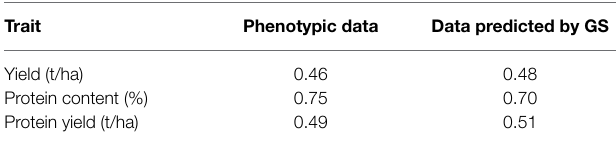
TABLE 8 | Correlation of phenotypic data or genomic selection (GS)-modelled data based on two test environments with data in a third (validation) environment, averaging results for all pairs test environments.